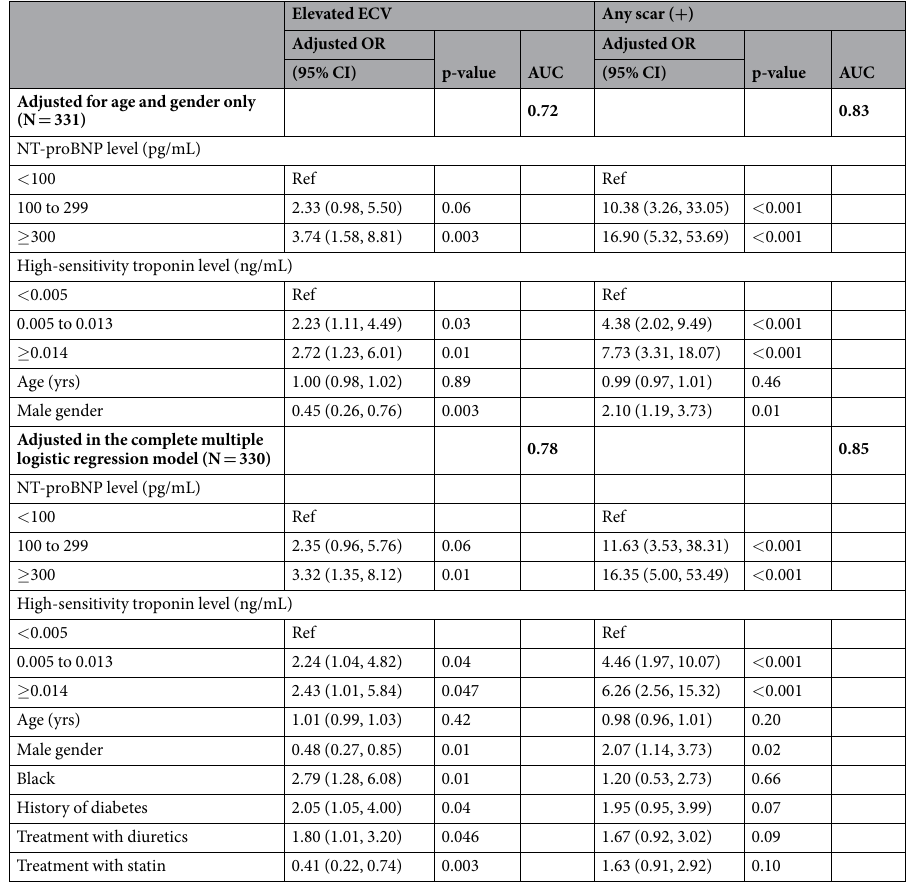
Table 6. Association between ECV or any scar with elevated NT-proBNP or high-sensitivity troponin, multiple logistic regression. ECV, extracellular volume; NT-proBNP, N-terminal pro B-type natriuretic peptide; OR, odds ratio; AUC, Area under the receiver operating characteristic curve